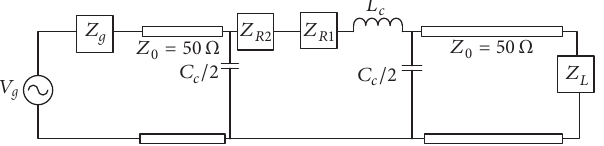
Figure 12: Top view of the antenna when 3.5 GHz split loop is rotated.